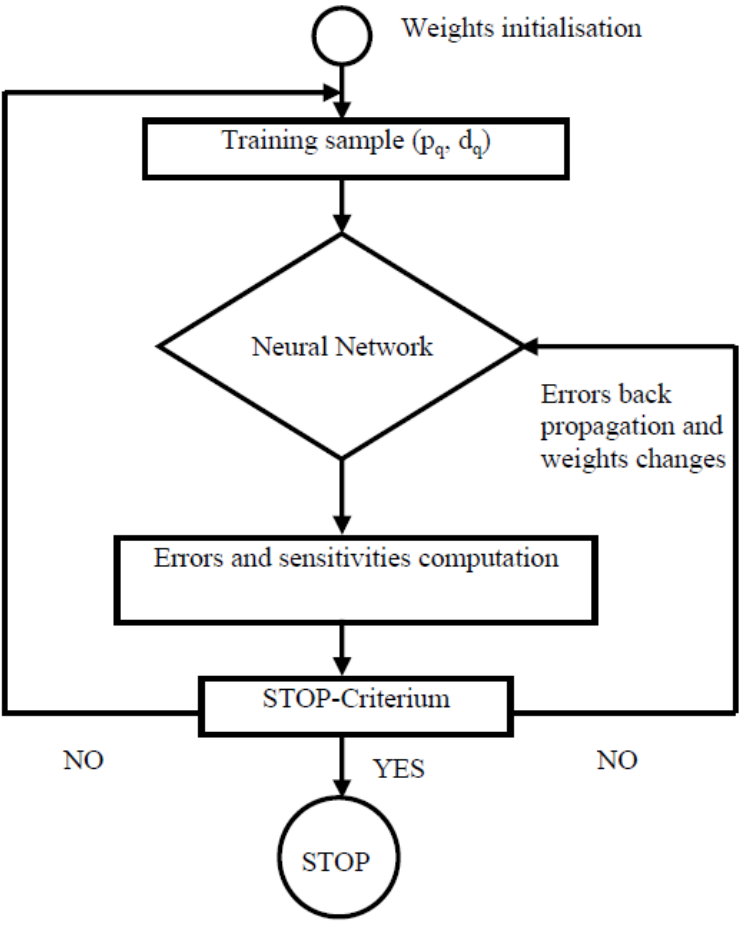
Figure 6. Diagram of the learning process of the neural